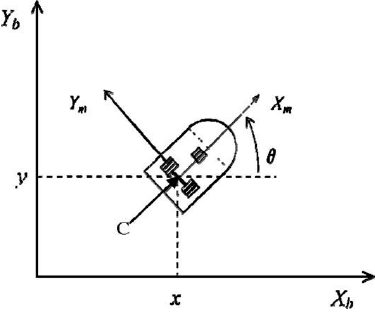
Figure 7. Scheme of the autonomous mobile robot.